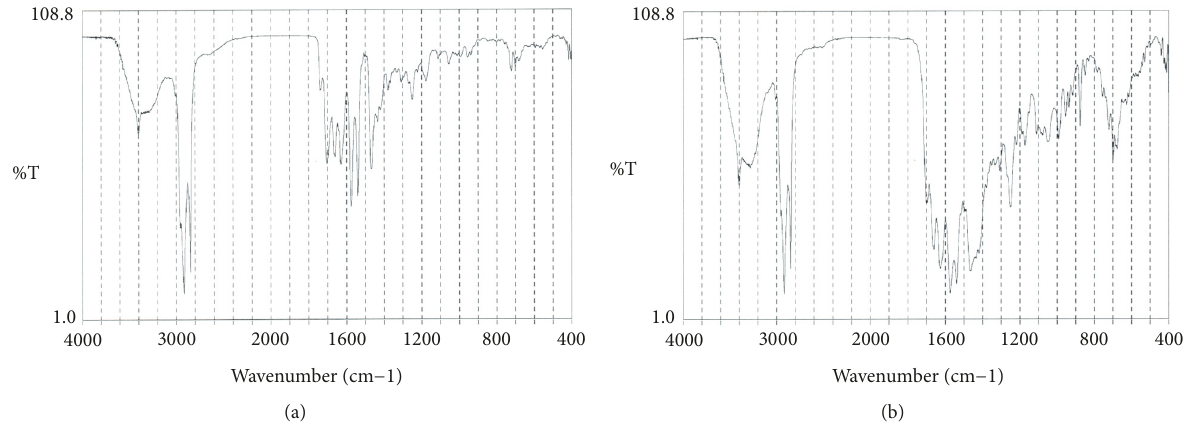
Figure 4: Infrared spectroscopy images. Infrared spectroscopy revealed that the external layer of the bezoar was composed of fatty acid calcium (61%) and bilirubin calcium (39%) (a). The core of the bezoar was composed of bilirubin calcium (48%), calcium carbonate (36%), and fatty acid calcium (16%) (b).